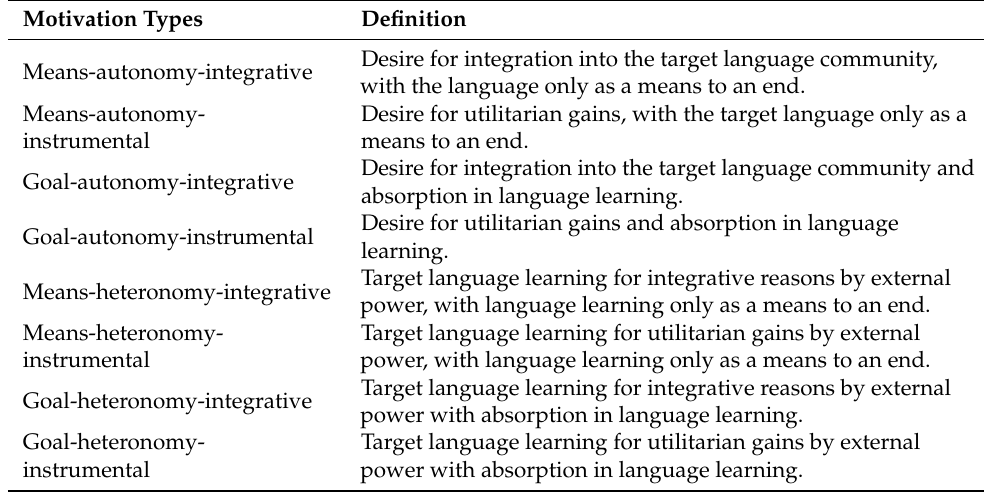
Table 1. Matsuzaka-Carreira’s motivation framework for English language